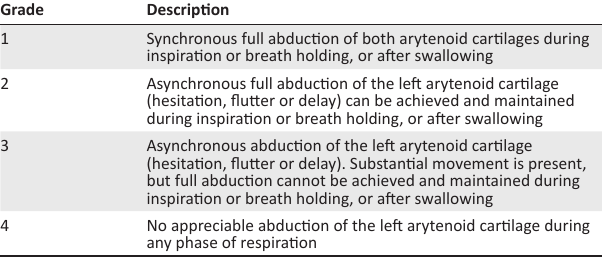
TABLE 2: Grading of recurrent laryngeal neuropathy.